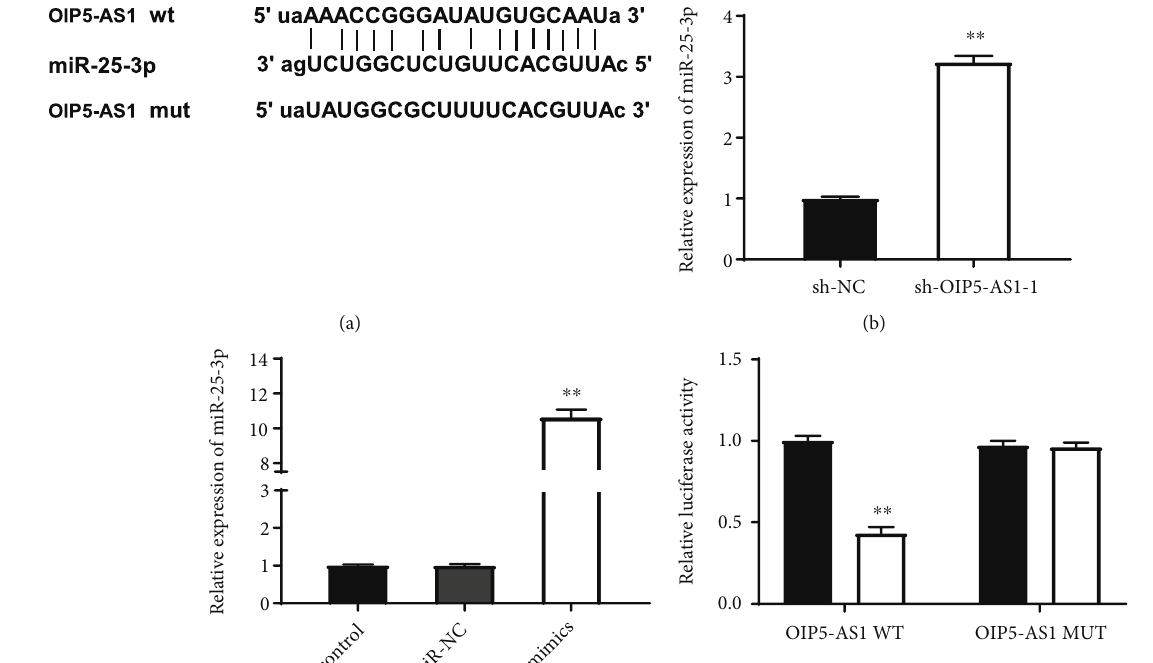
cells transfected or not transfected with pcDNA-OIP5-AS1